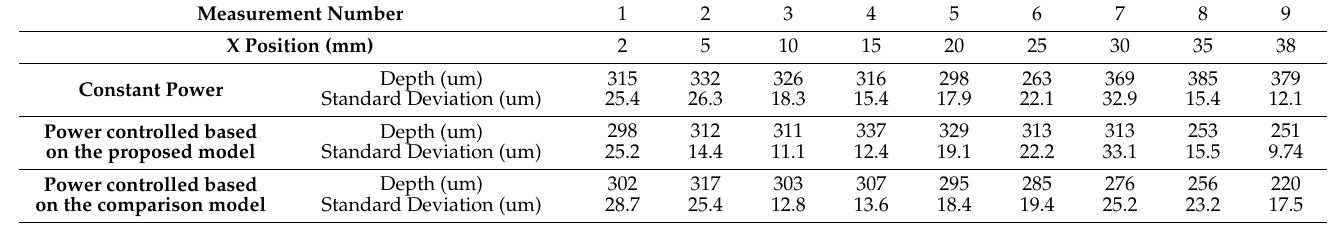
Table 8. Depth results of the variable-angle straight groove engraving.